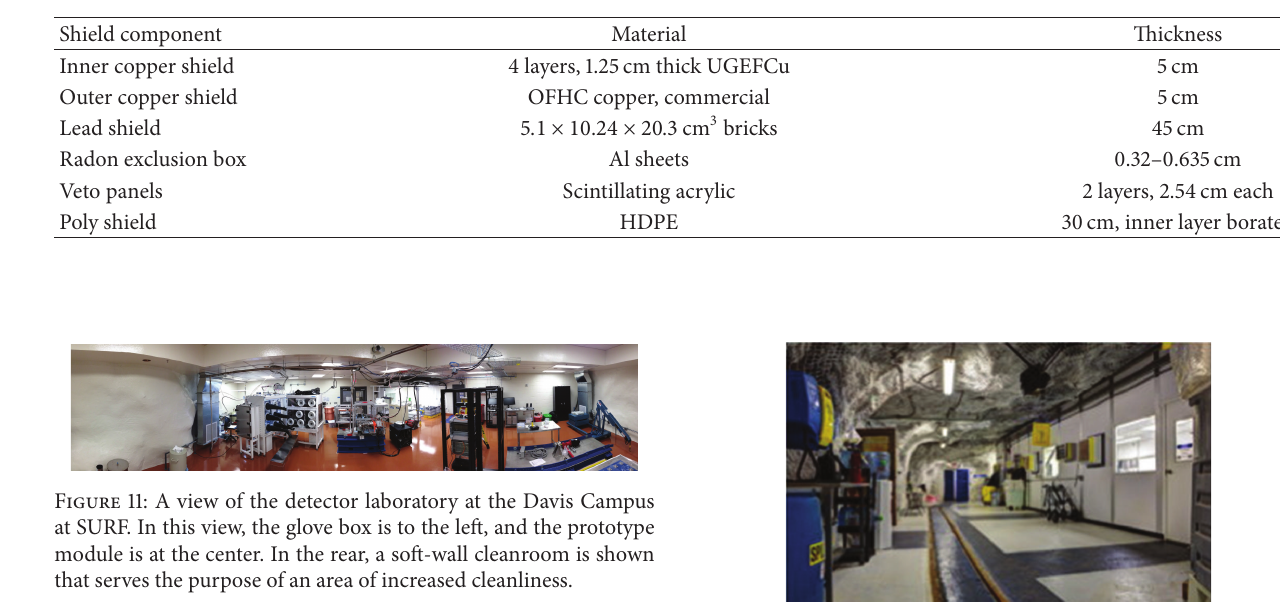
Table 1: A summary of the shield components.